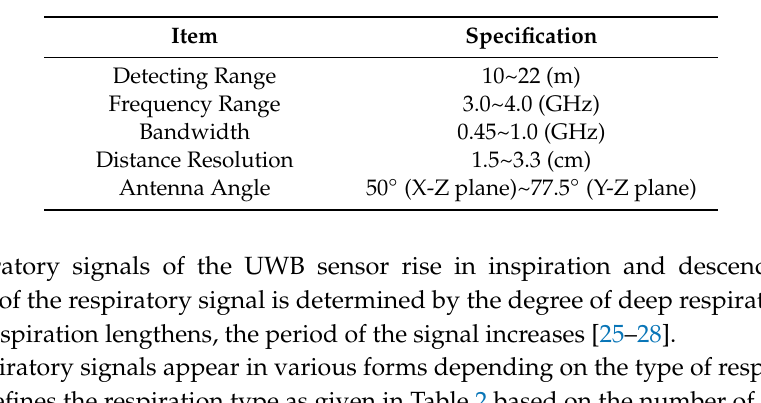
Table 1. Specifications of UWB sensor.